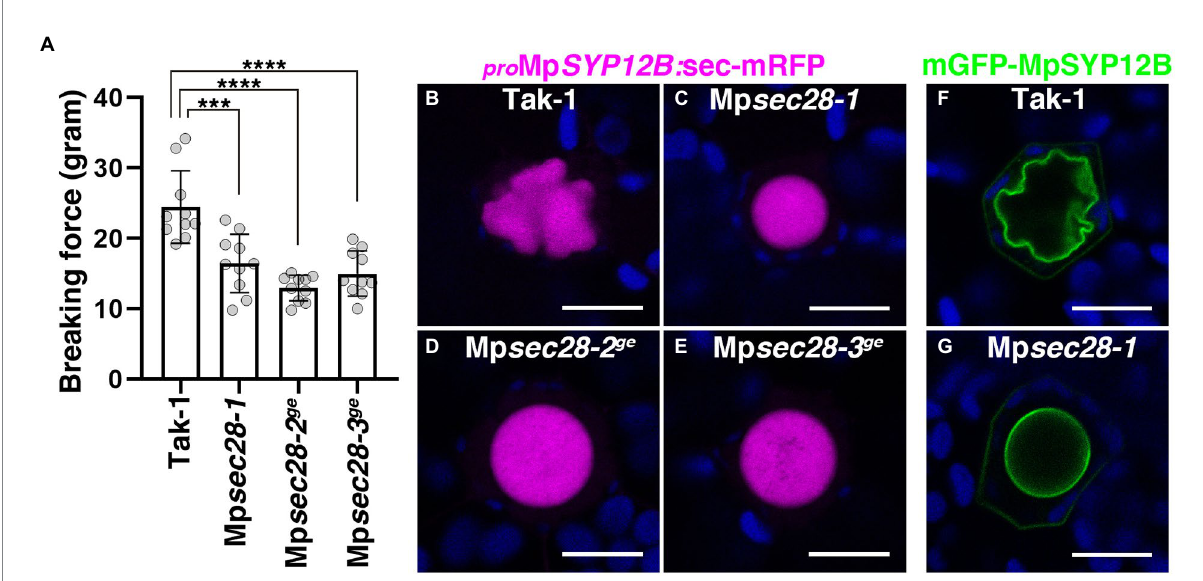
FIGURE 6 Effects of Mp sec28 mutations on thalli stiffness and transport to the oil body. (A) Semi-quantitative chopping assay. The force required to sever 12-day-old thalli was measured. Data are presented as the means ± s.d. Significant differences between Tak-1 and each genotype were statistically analyzed by a two-tailed Welch’s t -test. *** p < 0.005, **** p < 0.001. Ten thalli were analyzed for each genotype. p = 1.33 × 10 − 03 for Mp sec28-1 , p = 3.21 × 10 − 05 for Mp sec28-2 ge , and p = 1.79 × 10 − 04 for Mp sec28-3 ge . (B–E) Single confocal images of M . polymorpha thallus cells expressing sec- mRFP in Tak-1 (B) , Mp sec28-1 (C) , Mp sec28-2 ge (D) , and Mp sec28-3 ge (E) under the control of the Mp SYP12B promoter. (F,G) Single confocal images of M . polymorpha thallus cells expressing mGFP-MpSYP12B under the control of its regulatory elements in Tak-1 (F) and Mp sec28-1 (G) . Magenta, green, and blue pseudo-colors indicate fluorescence from mRFP, mGFP, and chlorophyll, respectively. Bars = 10 μ m. Representative images are shown among replicates. The Source data lists the number of observed